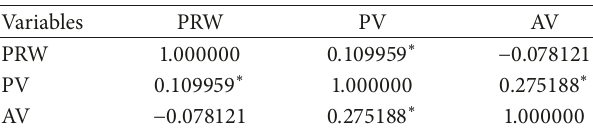
Table 7: Correlation analysis (Spearman’s 푟 ) between PRW, PV, and AV for the second period (1999-2000).